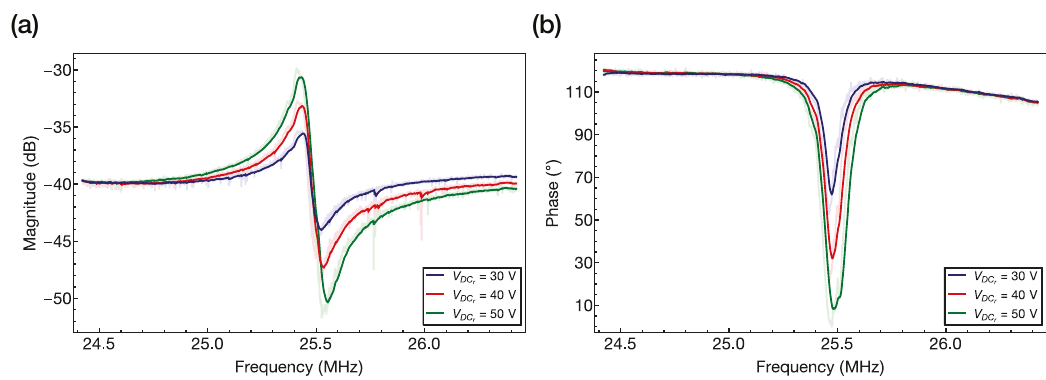
Figure 6. Experimental frequency response in air conditions of the capacitively detected suspended nanochannel microbridge resonator with monolithically integrated CMOS readout circuitry for different resonator DC voltages. The device has undergone the following wet etchings: 18 min + 18 min + 18 min + 10 min. ( a ) Magnitude frequency response. ( b ) Phase frequency response. Table 2. Geometry, dimensions, channel capacity, estimated mass, resonant frequency, mass sensitivity, and types of transduction for different state-of-the-art SMRs and this work’s device. The mass and mass sensitivity were calculated considering the resonators filled with water.